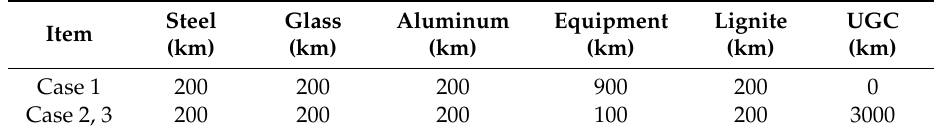
Table 12. The distance of each item.